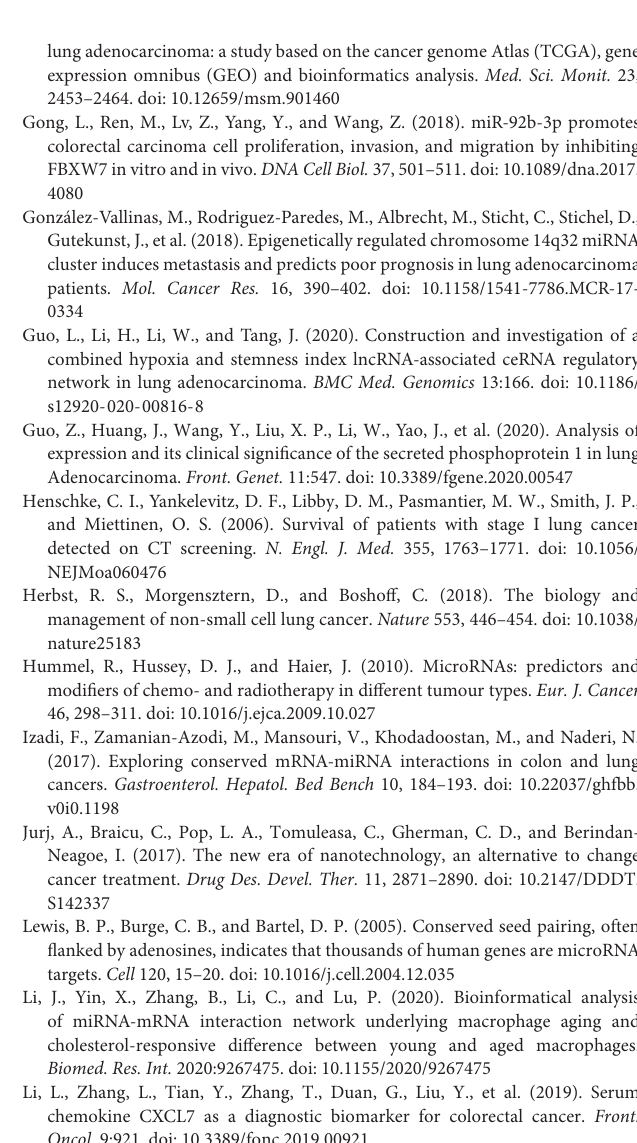
Supplementary Table S2 | Clinical characteristics of LUAD patients in the TCGA